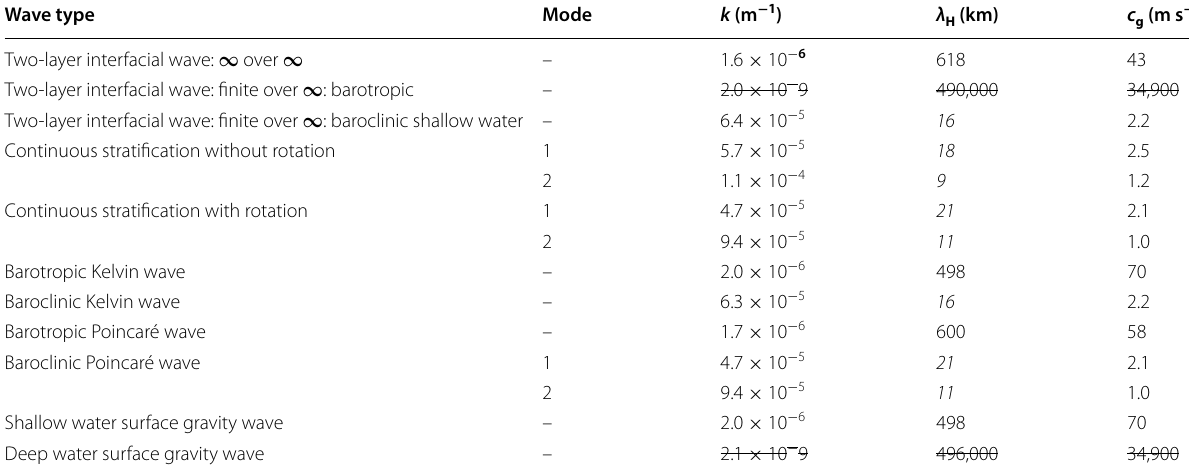
constituent (period 12.42 h; 2 =